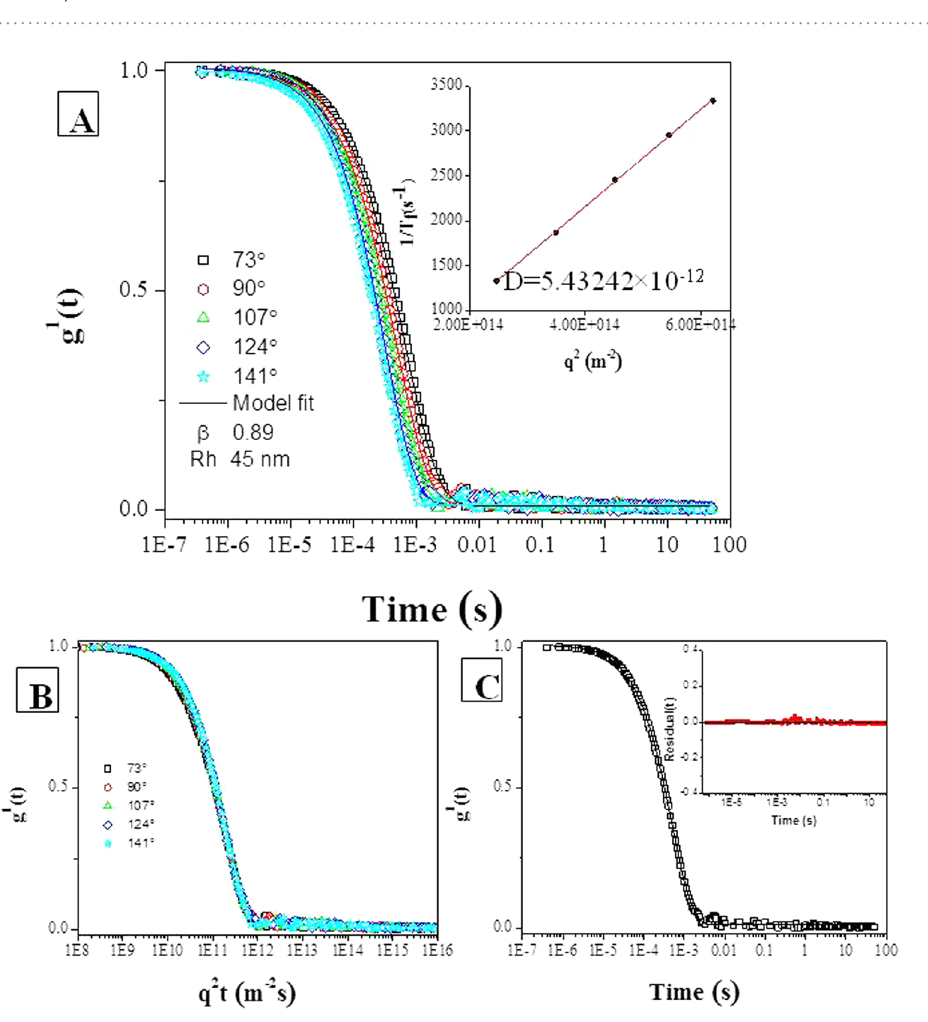
Figure 3. DLS of 1 mM ASNPs in PBS. ( A ) First-order electric field correlation functions versus time, together with curves fitted with the aid of Eq. 1, at the scattering angles indicated: The slope of inset plots ( τ − 1 versus q 2 ) is D, which is used to calculate R h . ( B ) First-order electric field correlation functions versus q 2 t are plotted at different angles. The condensation of the curves shows the diffusive behavior of the system. ( C ) First- order electric field correlation functions and their corresponding fits at 90°, the inset plot shows the random distribution and small values of the residuals. They indicate that the quality of the fit is